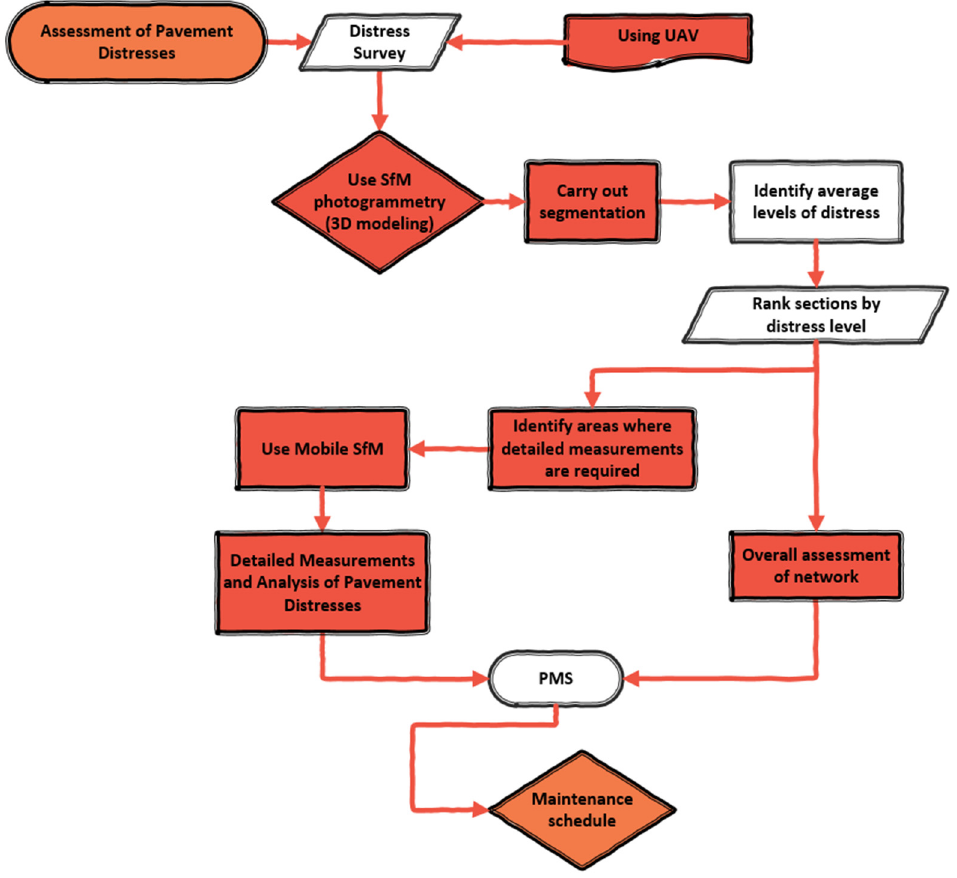
Figure 22. Workflow to utilize SfM techniques and information in PMS.